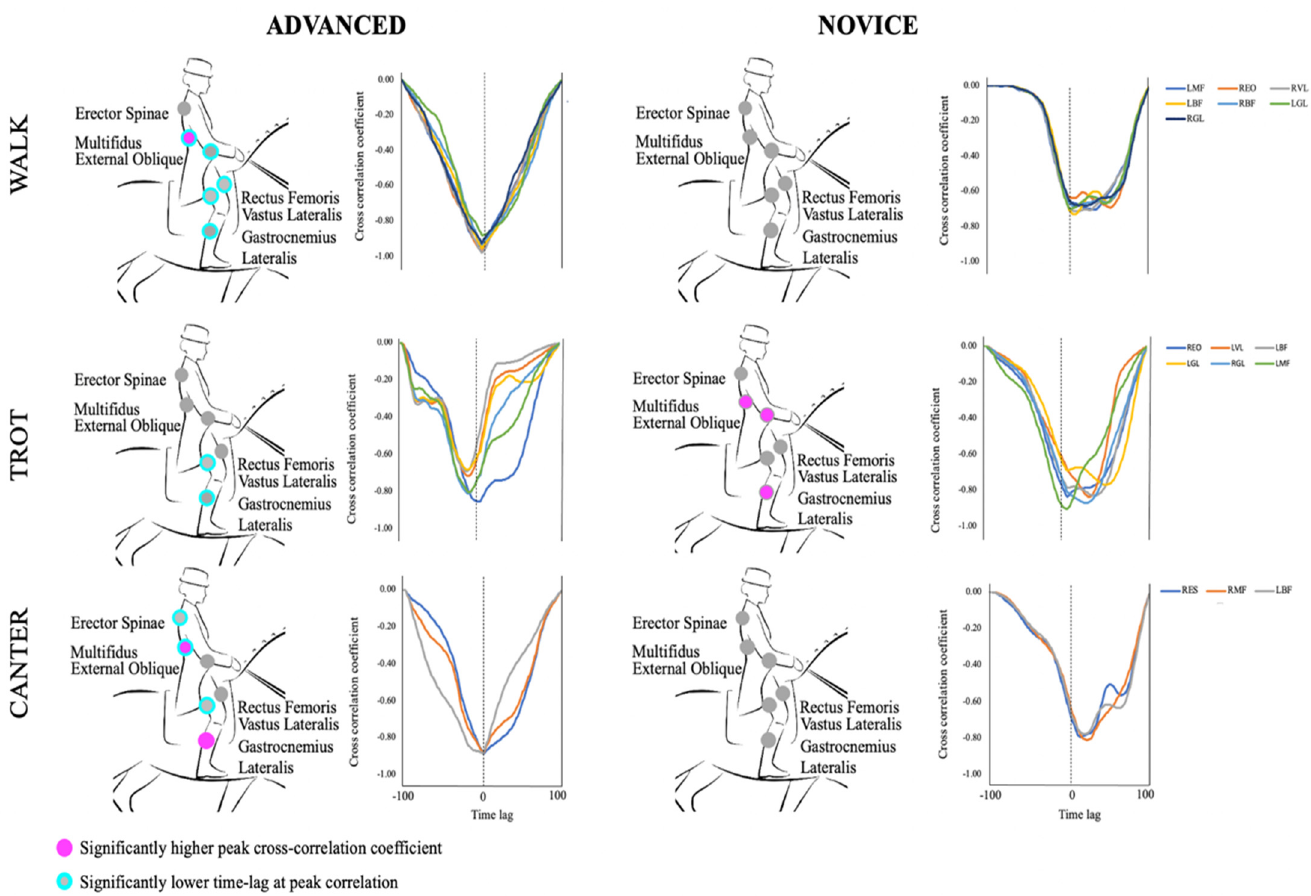
Figure 5. Schematical representation of significantly higher peak cross-correlations (magenta filled circle) and significantly earlier time lags at peak correlation (cyan circle) accompanied by a representative cross-correlation curve of novice and advanced riders.